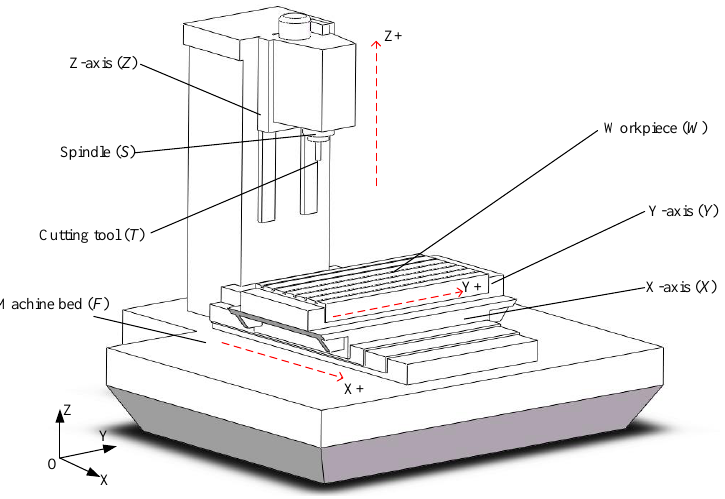
Figure 9. Structural diagram of another WYXFZT type three-axis machine